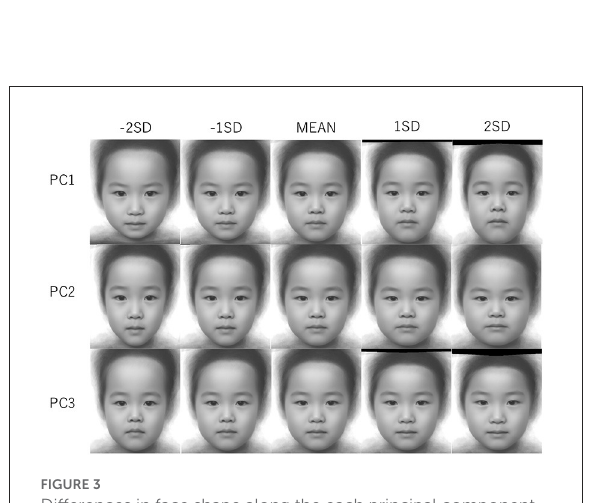
FIGURE3 Differences in face shape along the each principal component ( − 2 SD/ − SD/MEAN/+SD/+2 SD). The aspect ratios of the images were different from each other due to TPS warping.